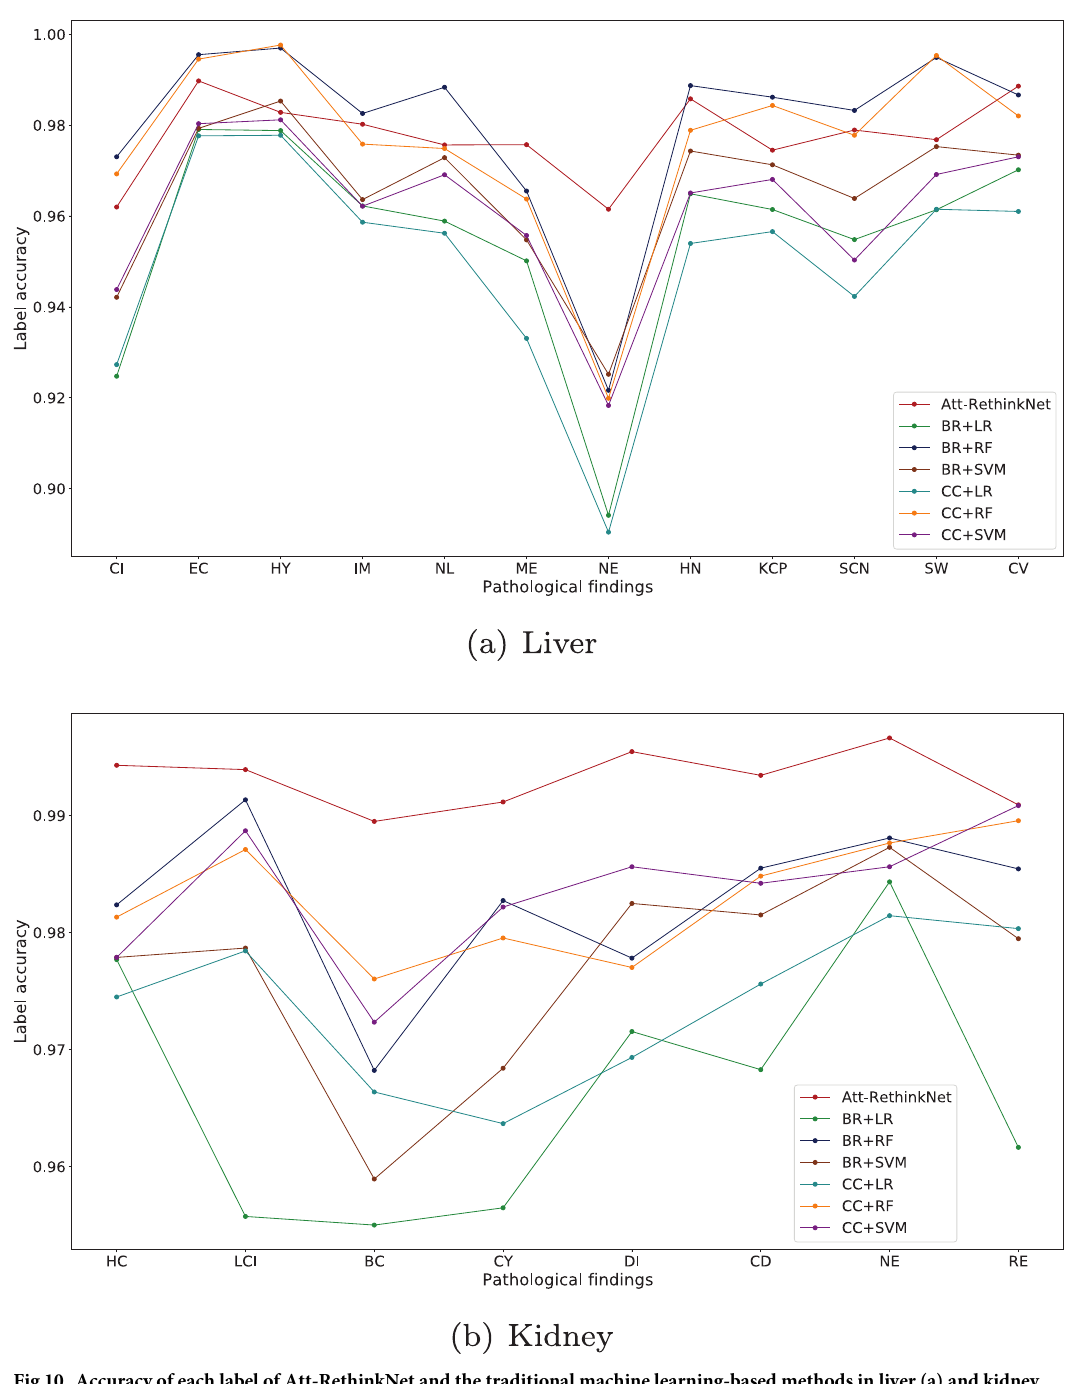
Fig 10. Accuracy of each label of Att-RethinkNet and the traditional machine learning-based methods in liver (a) and kidney (b).